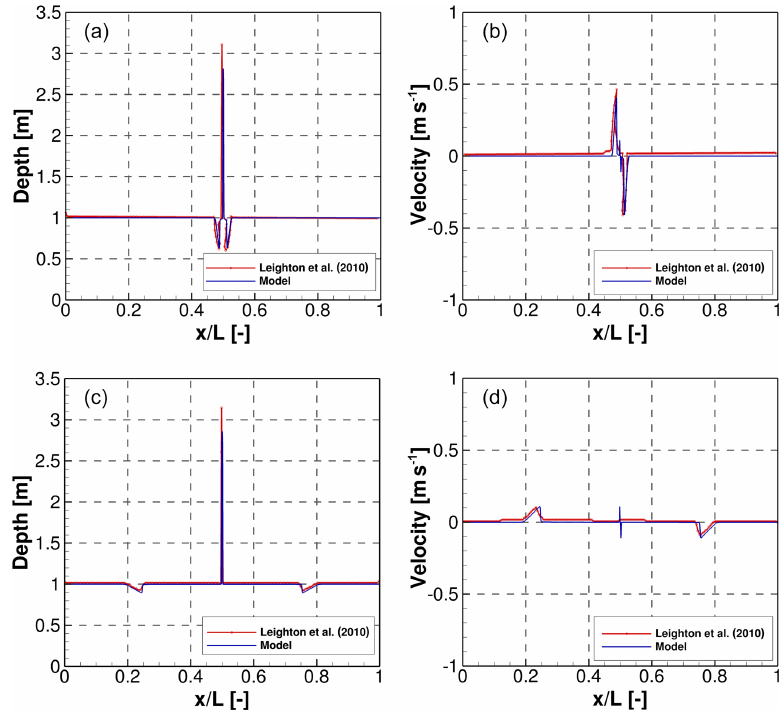
Figure B4. Density-driven dam break. Case ρ 2 = 0 . 1kgm − 3 : comparison of the flow depth (a, c) and velocity profiles (b, d) at (a, b) ˆ t = 2s and (c, d) ˆ t = 30s from the beginning of the simulation.